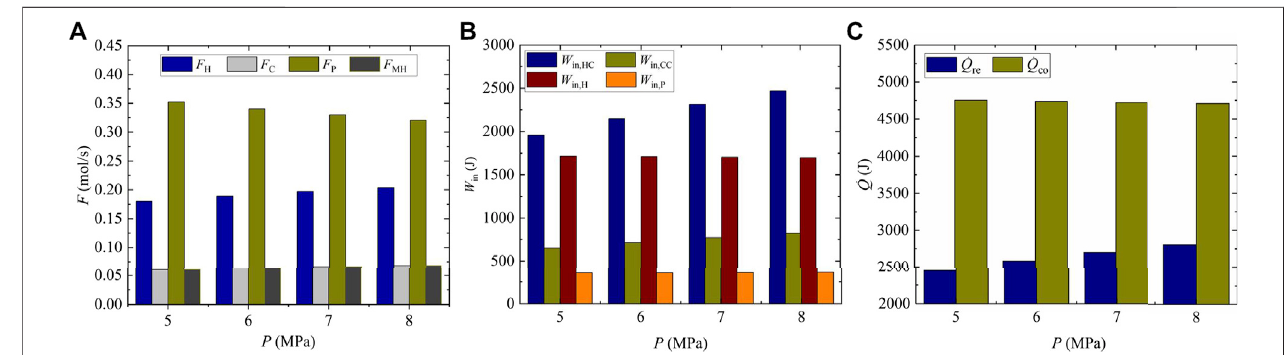
FIGURE 2 | Molar fl ow and input energy under different reaction pressures; (A) molar fl ow; (B) Input powers; (C) cold energy consumption.